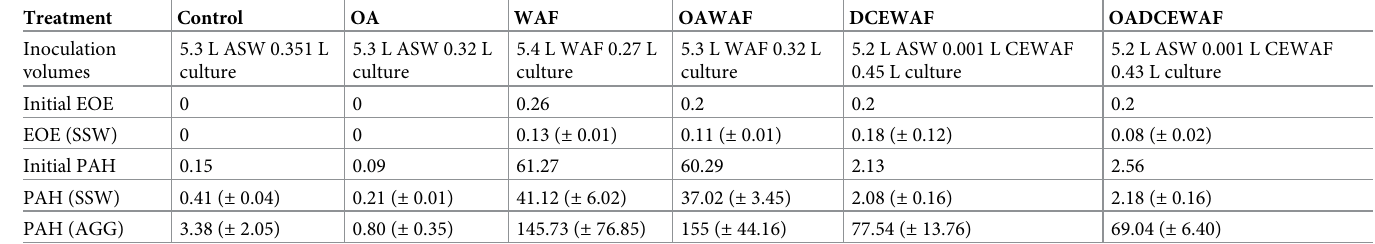
Table 3. Descriptions of the treatments used for the experiments. Initial (one sample) and final (triplicate) EOE (mg L -1 ) and initial PAH (ng L -1 ) and PAH ( μ g L -1 ) in SSW and AGG measurements are included. Error bars in brackets are standard deviation of triplicates. Treatment